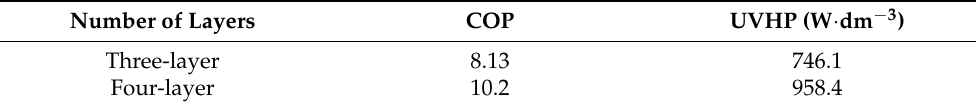
Table 4. Comparison of heating performance between the four-layer and three-layer EC heat